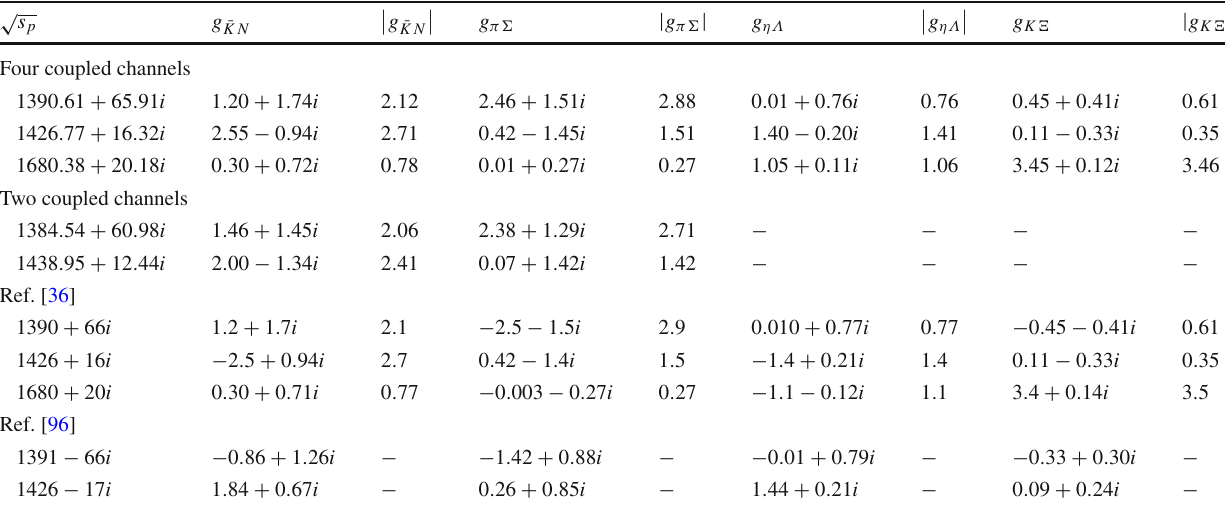
Table 2 Couplings for each coupled channel compared with the other works √ s p g ¯